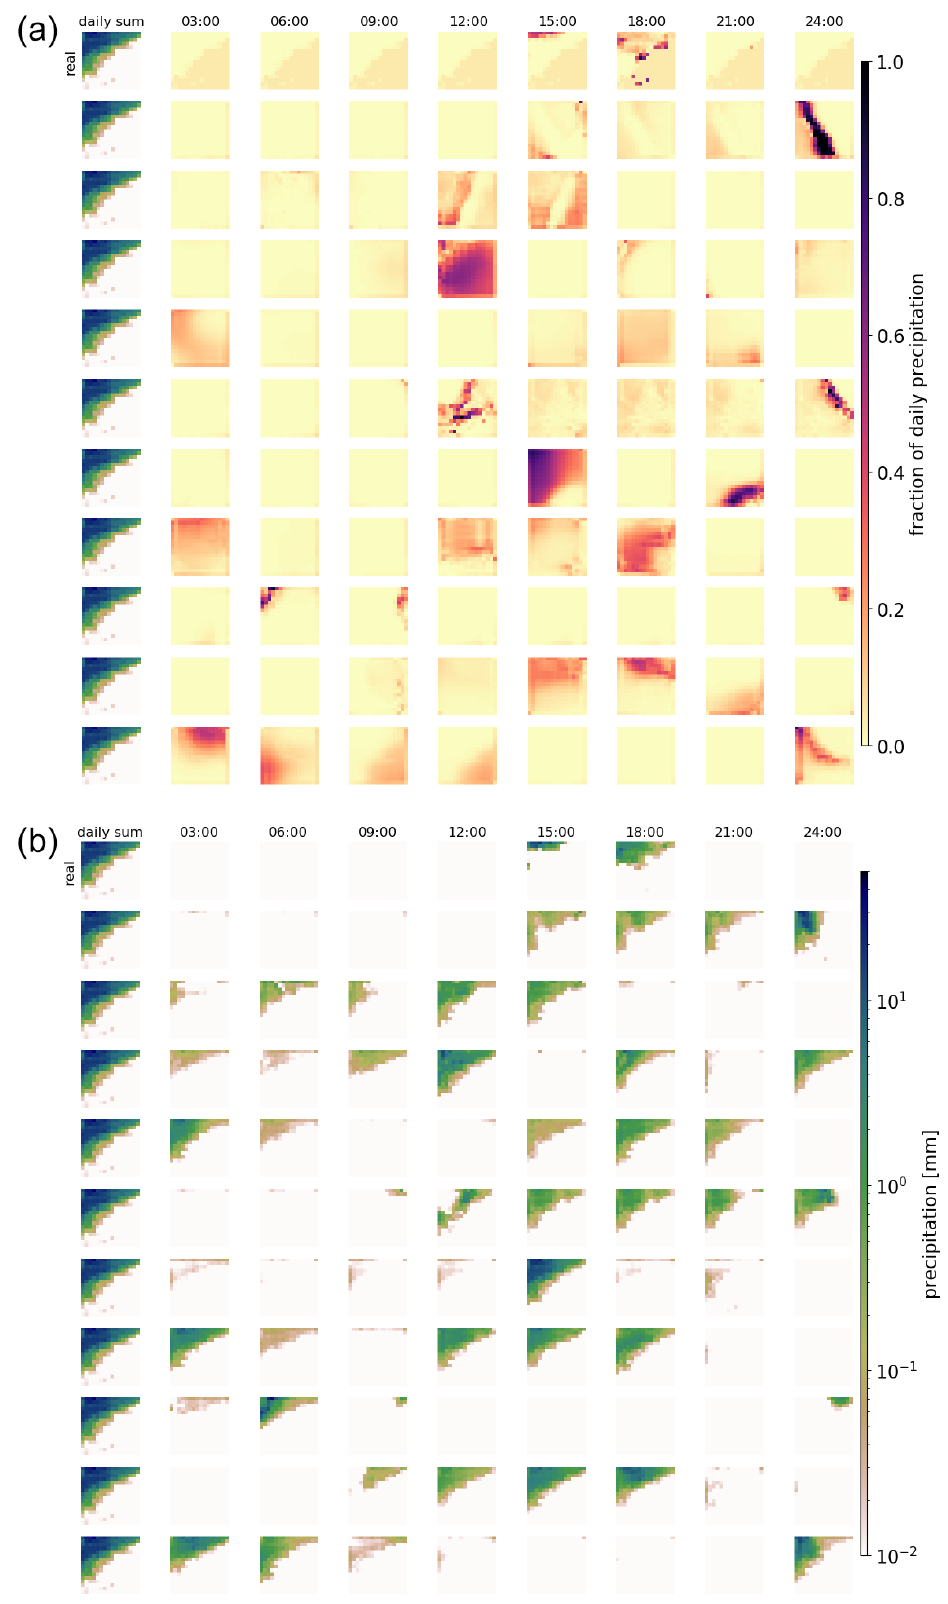
Figure 4. As Fig. 3, but for a different daily precipitation sum. Note that for very low precipitation amounts, fractions (panel a ) might still be